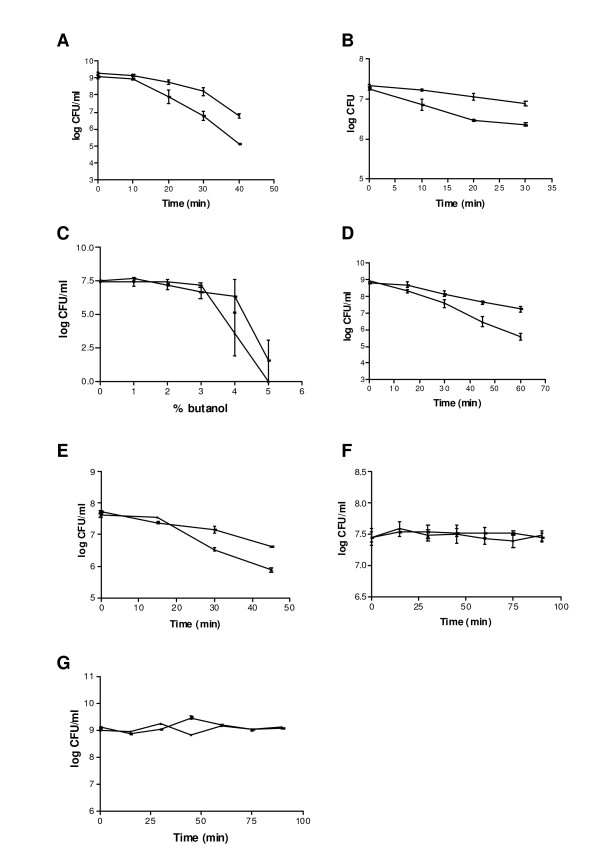
Effect of B. breve MCRA expression on survivability of L. lactis and C. glutamicum strains under stress conditions. A) Survivability of L. lactis pNZ8048 ('black square') versus pEMYL1 ('upside down black triangle') following heat treatment at 51°C for 40 min. ** Denotes value significantly different (p = 0.01) than control (pNZ8048). B) Survivability of C. glutamicum pCLIK ('black square') versus pEMYC2 ('black triangle') following heat treatment at 51°C for 30 min * Denotes value significantly different (p = 0.05) than control (C. glutamicum pCLIK). C) Survivability of C. glutamicum pCLIK ('upside down black triangle') versus pEMYC2 ('black square') following growth in 1-5% (v/v) butanol for 1 h. D) Survivability of L. lactis pNZ8048 ('black triangle') versus pEMYL1 ('black square') following nisin induction for 1.5 h prior to growth in 3% (v/v) butanol for 1 h. The experiments were done at least in triplicate. * Denotes value significantly different (p = 0.05) than control (pNZ8048). E) Survivability of C. glutamicum pCLIK ('upside down black triangle')versus pEMYC2 ('black square') following growth in 3% (v/v) butanol for 45 min. F) Survivability of C. glutamicum pCLIK ('black triangle')versus pEMYC2 ('black square') following growth in 4.8 M NaCl for 90 min. G) Survivability of L. lactis pNZ8048 ('black triangle') versus pEMYL1 ('black square') following nisin induction for 1.5 h prior to growth in 3 M NaCl for 90 min. The experiments were done in triplicate.